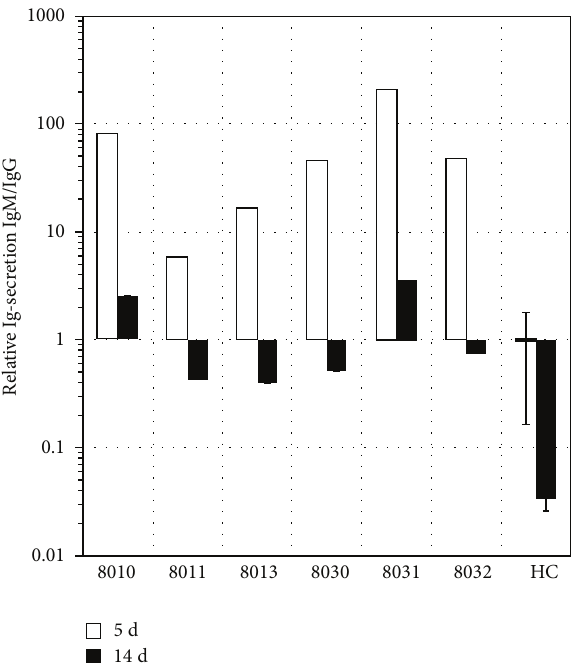
Figure 5: Isotype switching during culture of PPBL B cells with low CD154 interaction. The IgG and IgM secretion ratios of PPBL CD19 + cells stimulated with a low level of CD154 interaction were determined by ELISA in supernatant collected after 5 days (5d) and evaluated on day 14 (14d), for all patient samples. Four healthycontrolssubmittedtoidenticalcultureconditions(HC)were analyzed similarly and data is presented as the mean ±